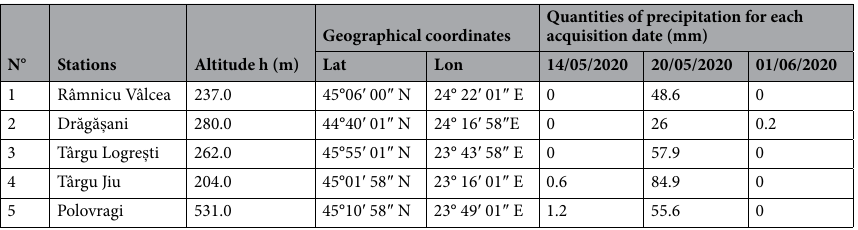
Table 5. Daily quantities of precipitation at weather stations (WS) according National Meteorological Administration.